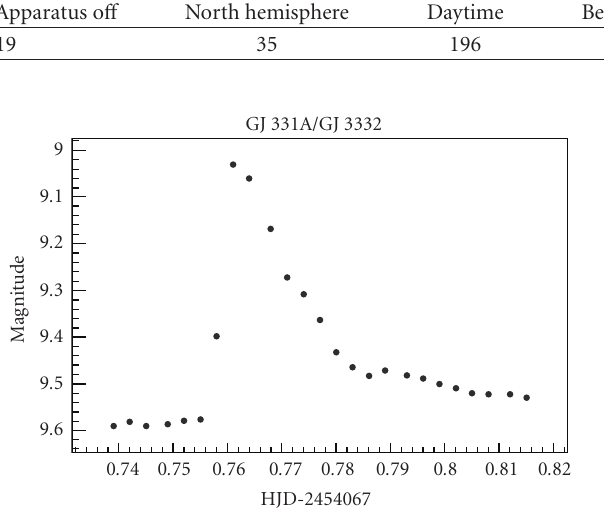
Figure 9: During the night 27/28.11.2006 the “Pi of the Sky” automatically detected outburst of a flare star GJ3331A/GJ3332 ( α = 05 :06 :50, δ = − 21 :35: 06). Each point on the light curve corresponds to a sum of 20 images, 10 second exposure each.